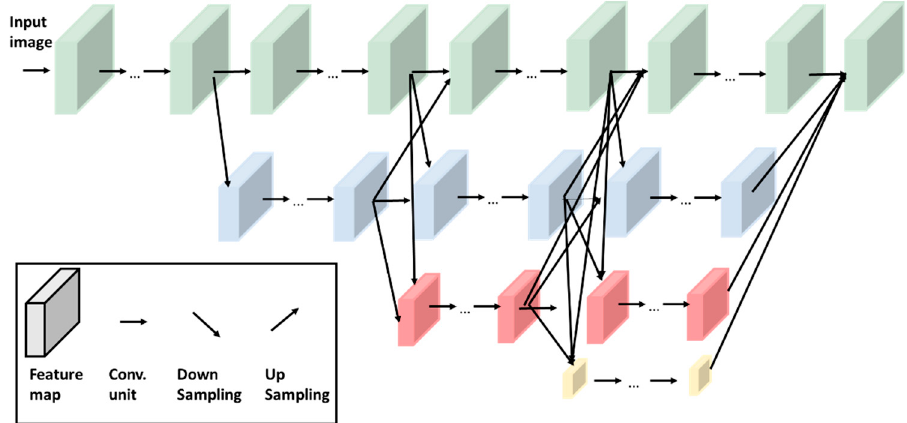
Figure 6. Schematic diagrams of HRNet’s network structure.